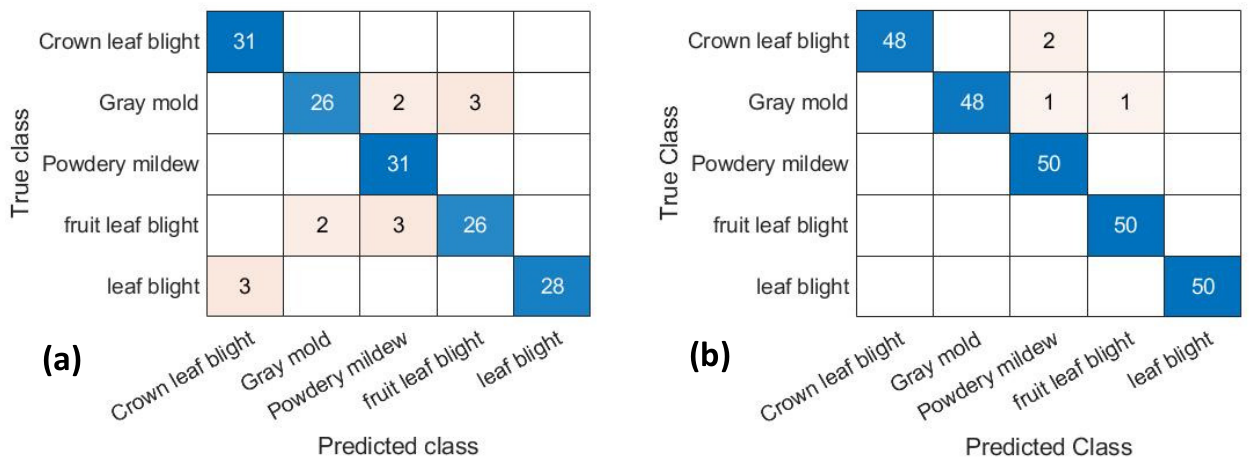
Figure 1. Confusion matrix with the GoogLeNet model of 20 epochs of the ( a ) original dataset, and ( b ) feature dataset.